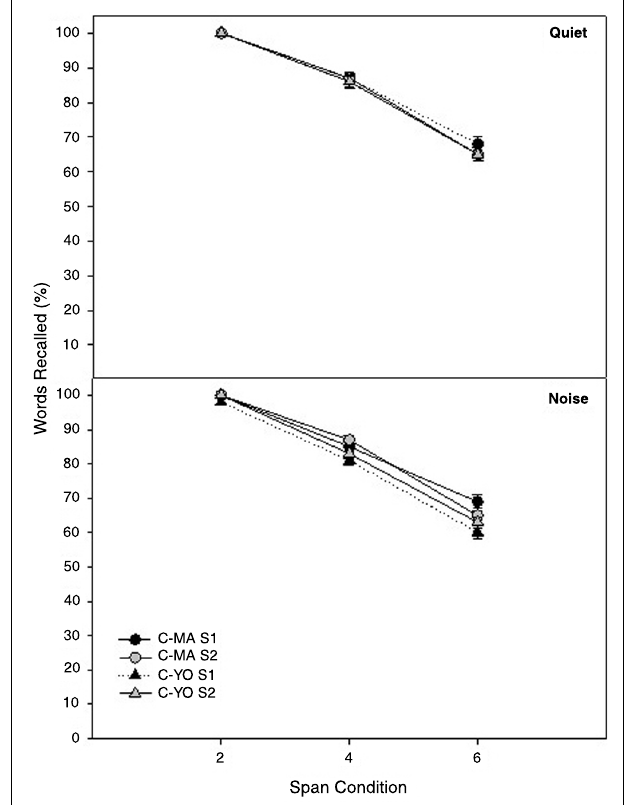
FIGURE 3 | Mean Listening Span test scores in quiet (top) and noise (bottom) for the two age-matched control groups [C-MA (circles) and C-YO (triangles)] for test sessions 1 and 2. Error bars represent (cid:6) 1